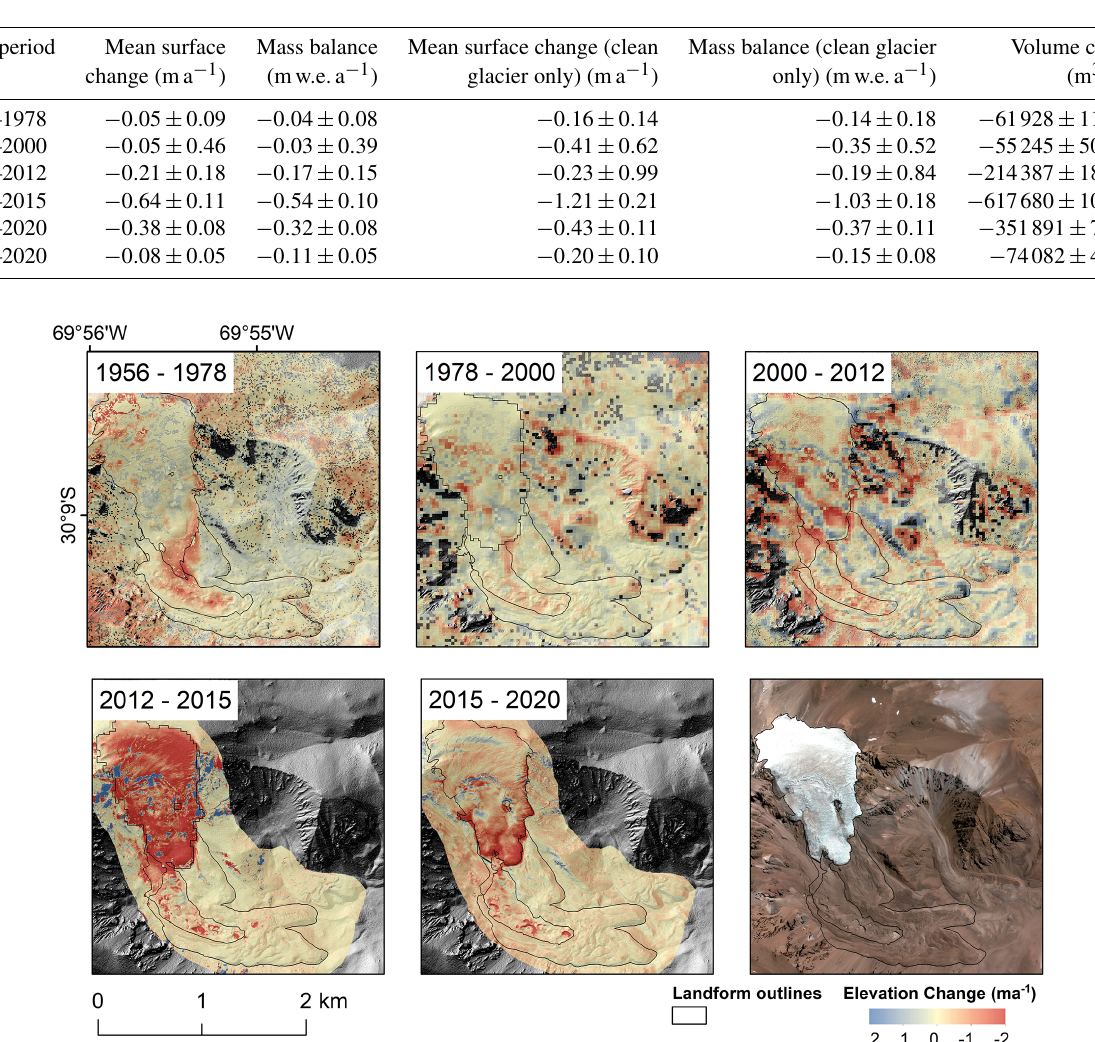
Figure 4. Mean annual surface elevation changes for Tapado Glacier between 1956 and 2020. The outline for the Tapado Glacier–rock glacier complex are shown, along with subdivisions for the clean ice section, debris-covered ice section, and rock glacier